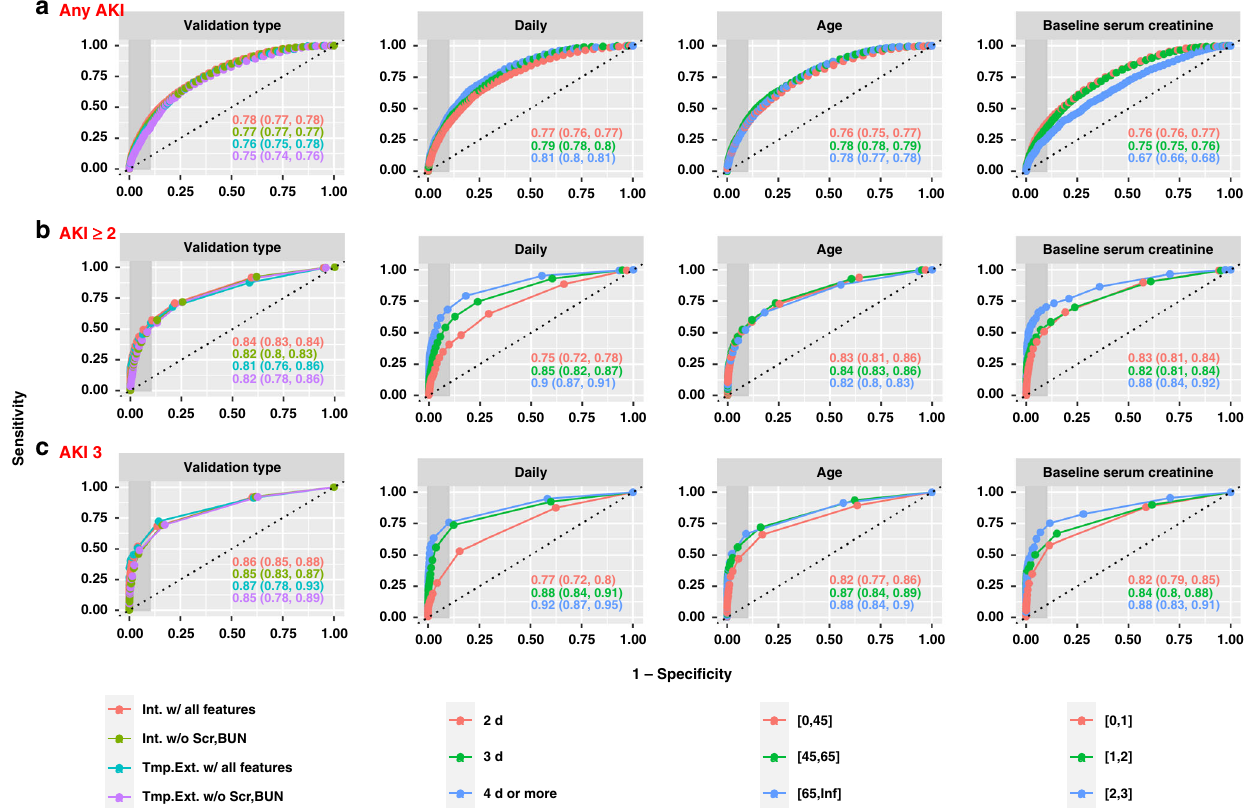
Fig. 1 Model performance on the source health system data. Model performance on the source health system data illustrated by receiver operating characteristic curves for predicting AKI events of any severity ( a ), at least stage 2 ( b ), or stage 3 ( c ) within the next 48-hours for various subgroups. “ Int. w/ all features ” refers to internal validation of models, i.e., random train/test sample split, using all extracted EHR features; “ Int. w/o Scr, BUN ” refers to internal validation of models that excludes SCr and BUN in all forms; “ Tmp. Ext. w/ all features ” refers to temporal validation of models, i.e., temporal hold- out set, using all extracted EHR features; “ Tmp. Ext. w/o Scr, BUN ” refers to temporal validation of models excluding SCr and BUN in all